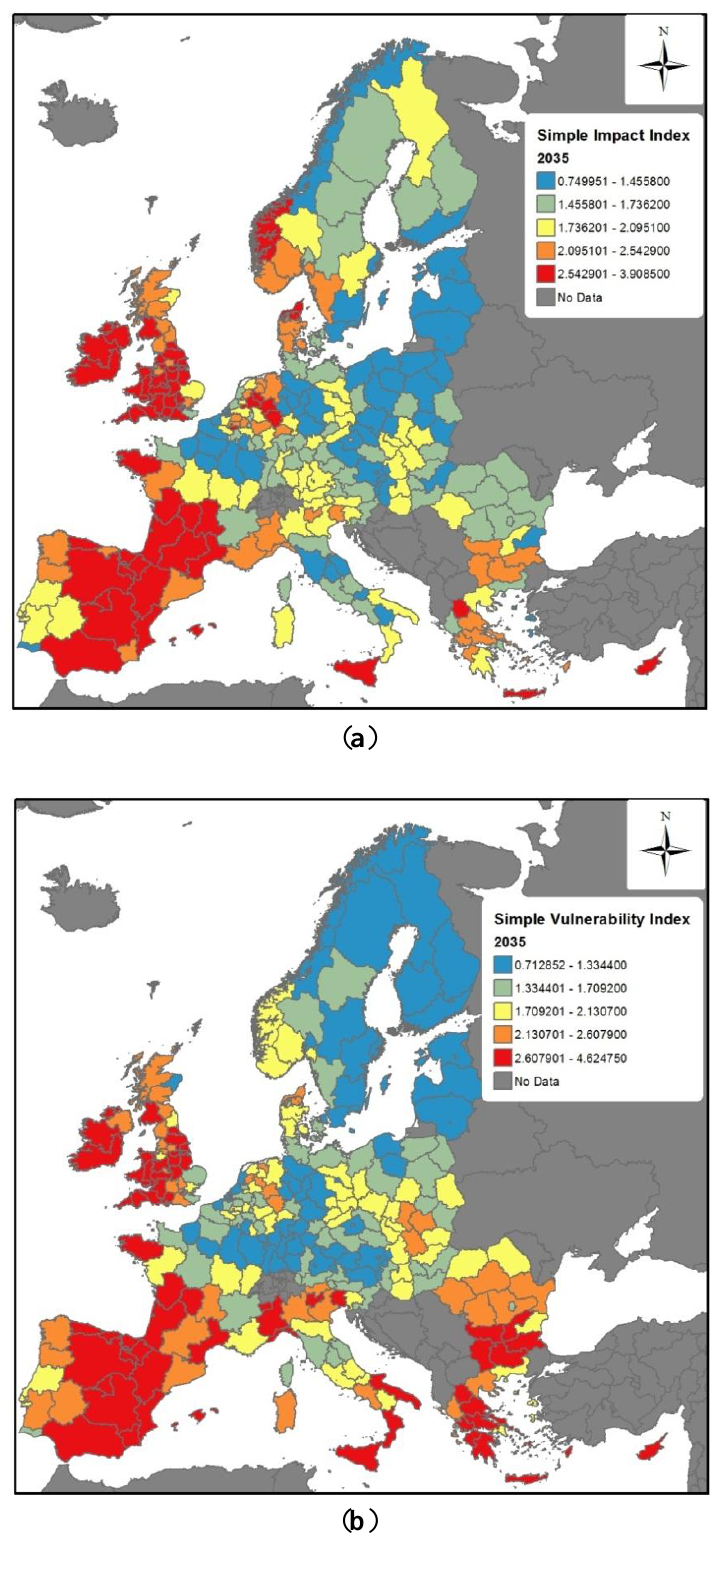
Figure 3. Vulnerability Index projected for 2035: ( a ) Impact Index; ( b )Vulnerability